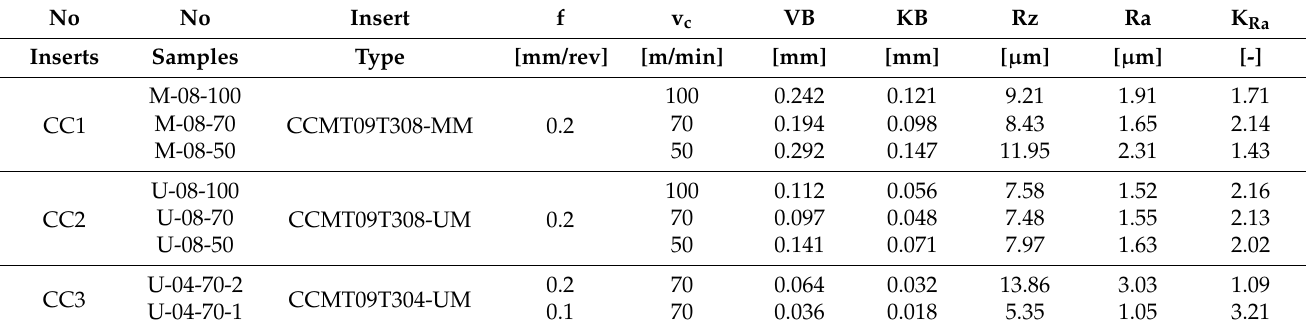
Table 3. The parameters of the surface roughness and tool wear of a cutting edge of samples DSS after turning. No Inserts